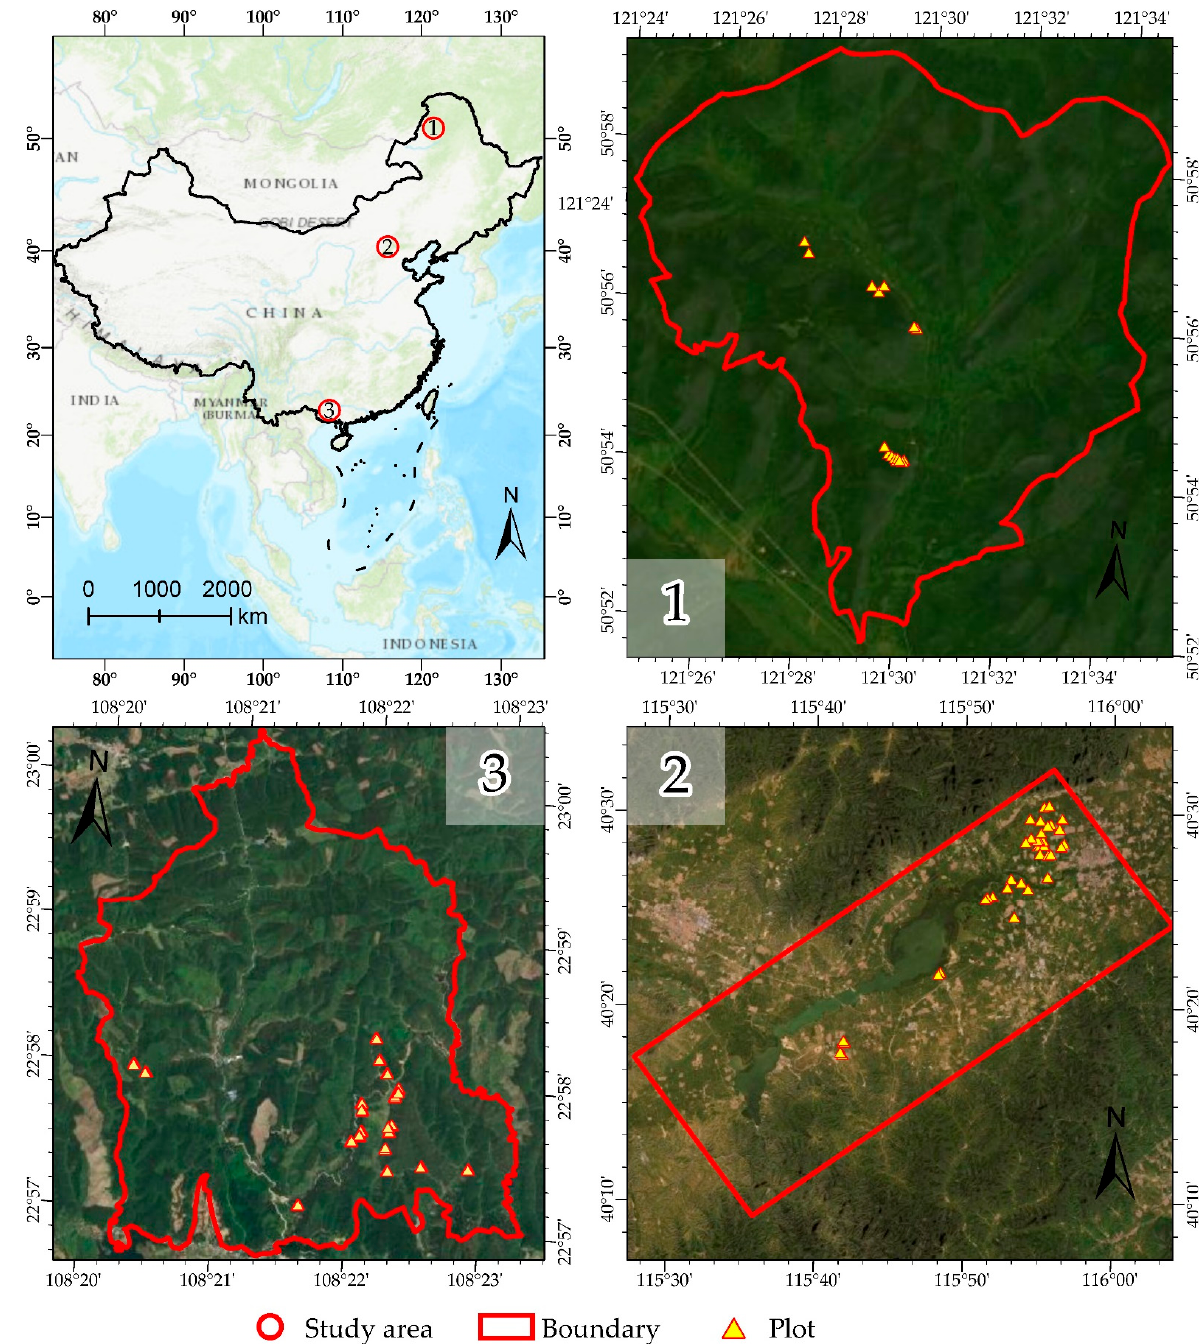
Figure 1. Spatial distribution of the three study areas: (1) the Greater Khingan Station, (2) the Huailai Remote Sensing Comprehensive Experimental Station, and (3) the Gaofeng forest